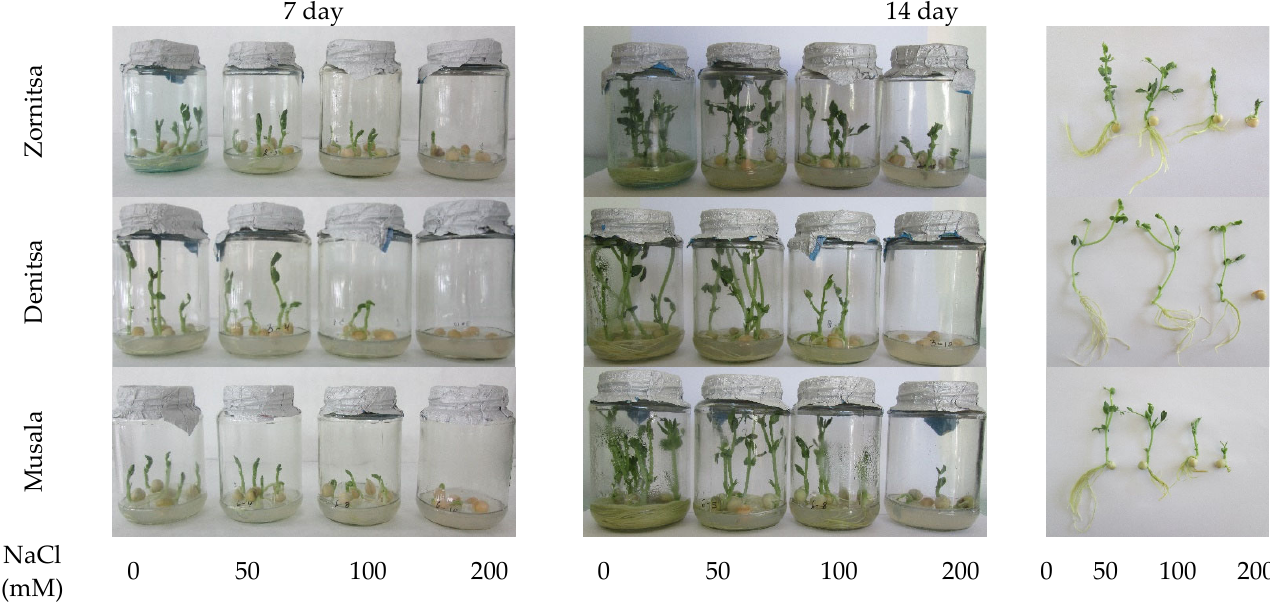
Figure 2. The effect of salt stress on seed germination and seedling emergence rate of selected garden pea genotypes after 7 and 14 days in vitro cultivation of medium containing 0, 50, 100, and 200 mM NaCl.